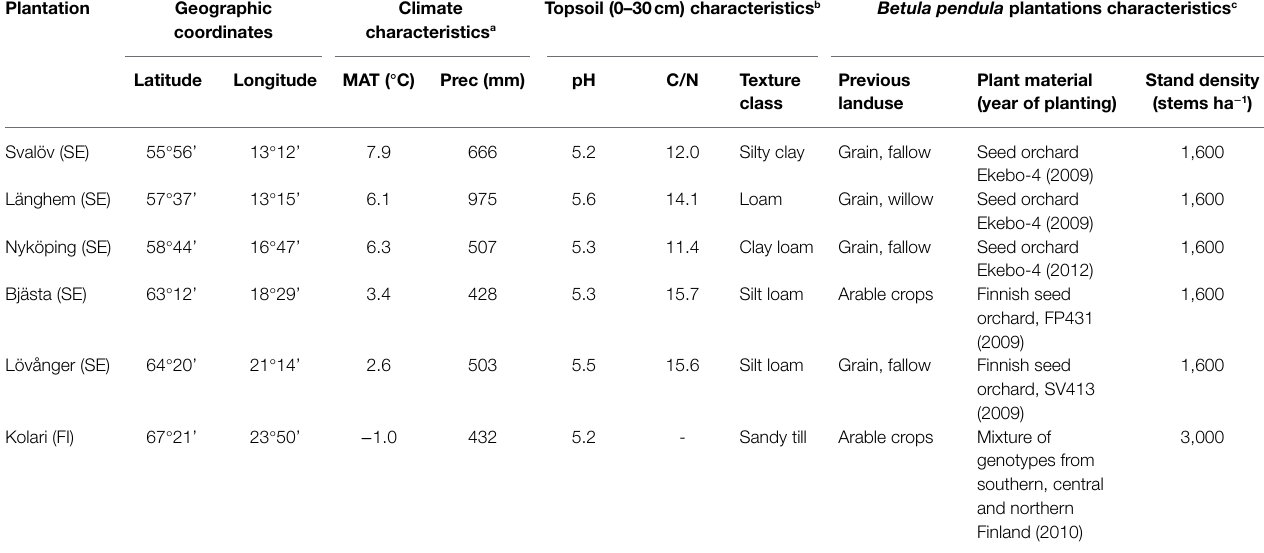
TABLE 1 | Study site and plantation